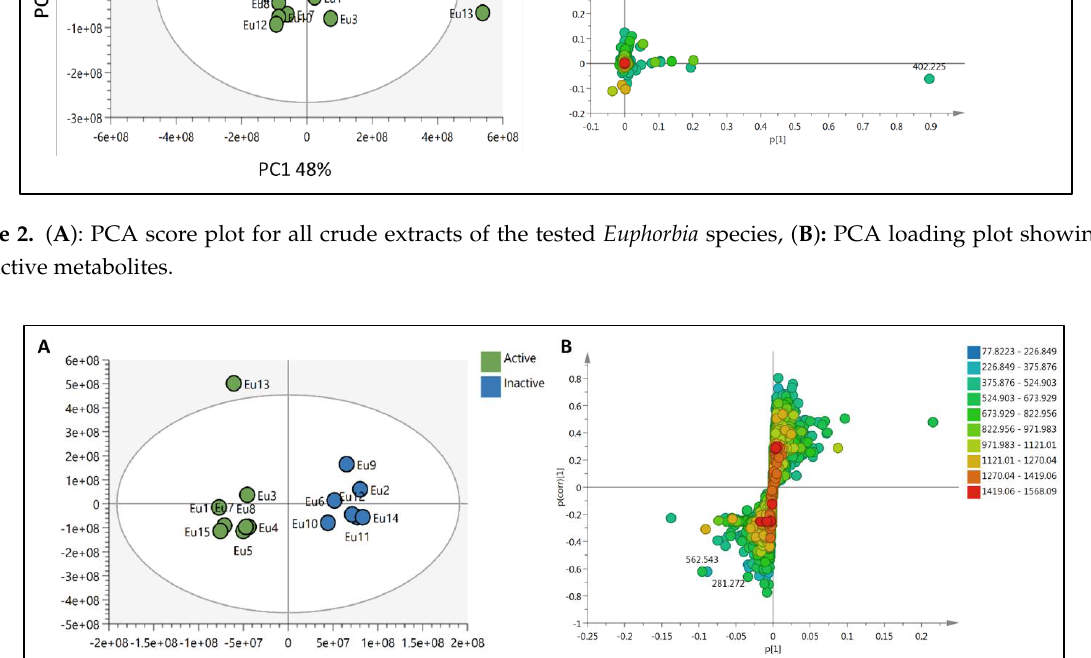
Figure 3. ( A ) : The whole molecular network showing the clusters of different features. ( B ) : extracted network showing the metabolites highly correlated to the cytotoxic activity against MCF-7 and HPEG2. Nodes are colored in pie chart and molecules grouped according to their concentration in the tested species. Edges are correlation values and the edge’s width is proportional with this value .